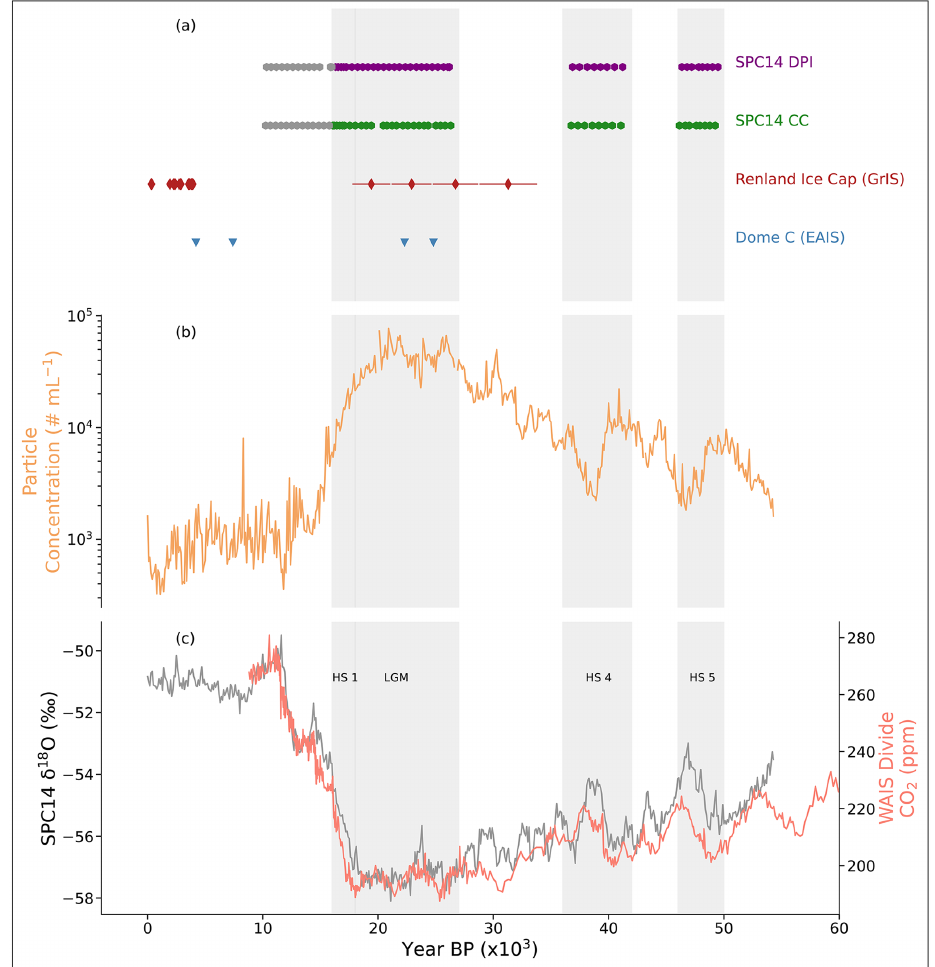
Figure 1. (a) Ages of discrete particle shape analyses in this study compared to previously published research on particle shape variability during the last glacial period (LGP): Potenza et al. (2016; Dome C, Antarctica; blue); Simonsen et al. (2018; Renland Ice Cap, Greenland; red); SPC14 CC (present study; green); and SPC14 DPI (present study; purple). Grey SPC14 CC and DPI markers represent samples that were run (see Methods). (b) SPC14 dust particle concentration (present study; light brown), (c) δ 18 O from Steig et al. (2021; grey), and WAIS Divide CO 2 (Bauska et al., 2021; Marcott et al., 2014; salmon) are shown for context. Grey bars highlight time periods of interest in our